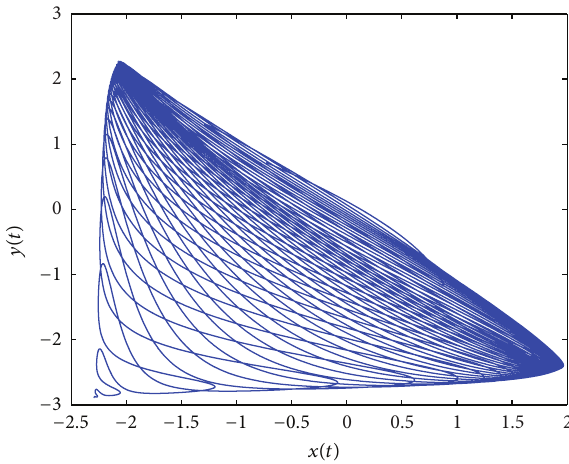
Figure 2: The phase diagram of the original system